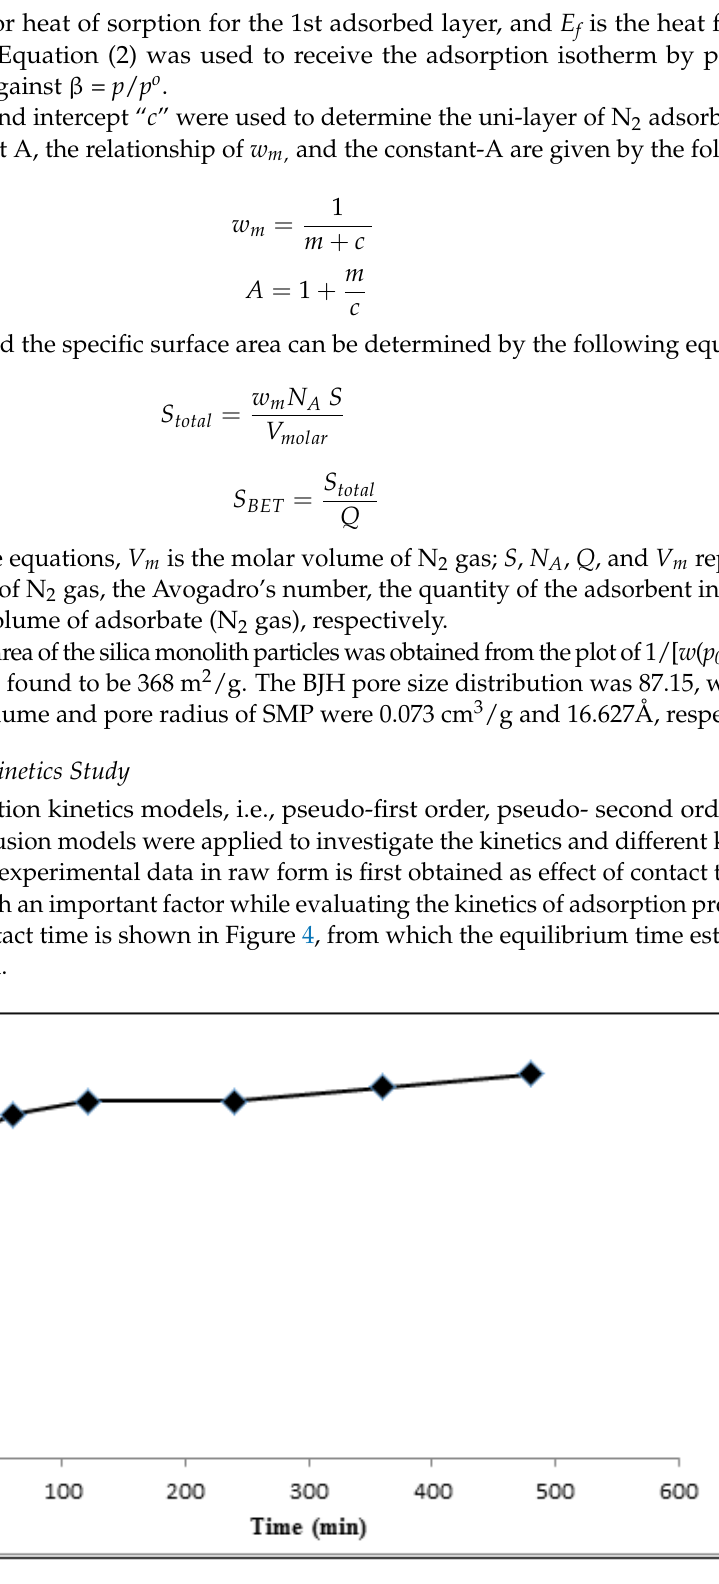
Figure 4. Effect of contact time on the adsorption of BR-5 on SMPs.